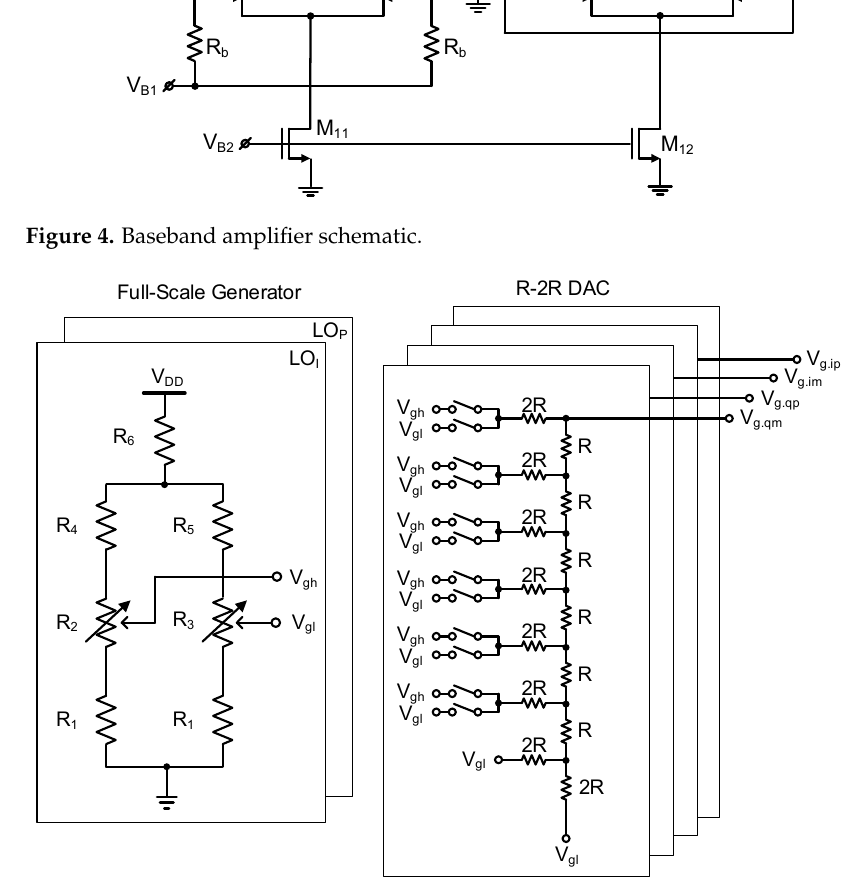
Figure 5. Voltage digital ‐ to ‐ analog converter (VDAC) schematic.